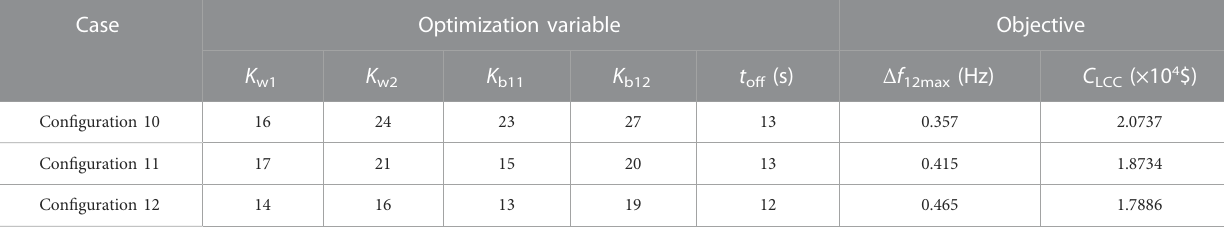
TABLE 7 Optimization results without considering SFD. Case